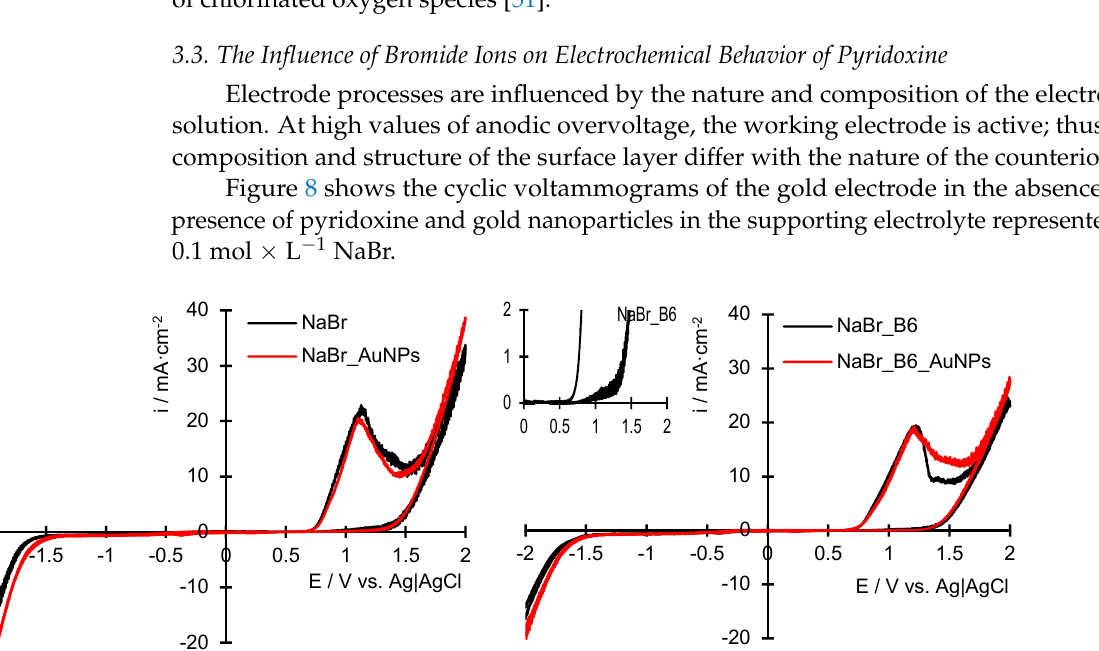
Figure 8. Cyclic voltammetry responses of gold electrode in 0.1 mol × L − 1 NaBr support electrolyte in the absence and in the presence of 75 mg × L − 1 gold nanoparticles (AuNPs) and 2.9 × 10 − 4 mol × L − 1 pyridoxine (vitamin B 6 ).